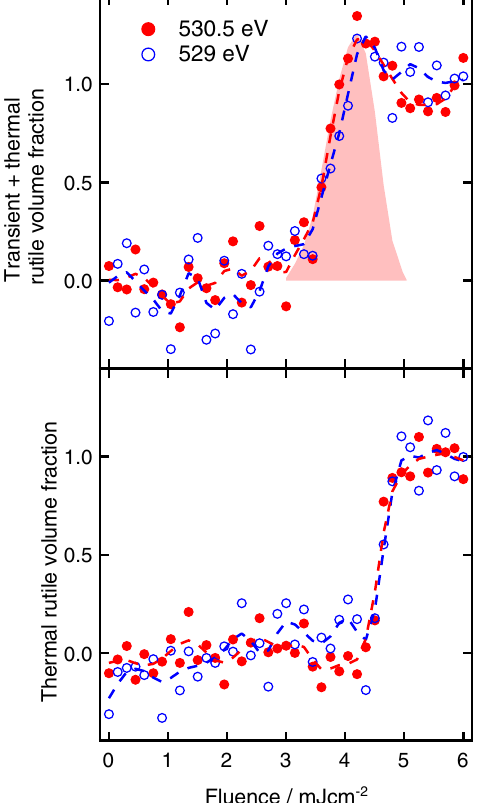
FIG. 4. Fluence dependence of the rutile phase volume fraction obtained from the XAS response at 530.5 eV (filled red circles) and 529 eV (blue open circles). (a) Maximum rutile phase volume fraction deduced from the XAS spectra measured 400 ps after photoexcitation. This fraction includes both the transiently induced change and the quasistatic thermal change. (b) Volume fraction obtained 4 ms after excitation, which shows the quasi- static volume fraction of the rutile phase. The dashed lines show the data smoothed. The shaded area corresponds to the region in which a transient phase transition is